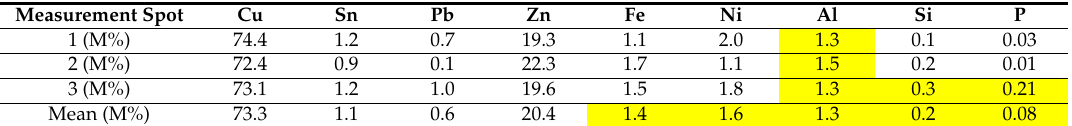
Table 2. Results of environmental scanning electron microscopy–energy dispersive X-ray analysis (ESEM/EDX) (object 4) (concentrations contradicting alleged production date are indicated in yellow). Measurement Spot Cu Sn Pb Zn Fe Ni Al Si P 1